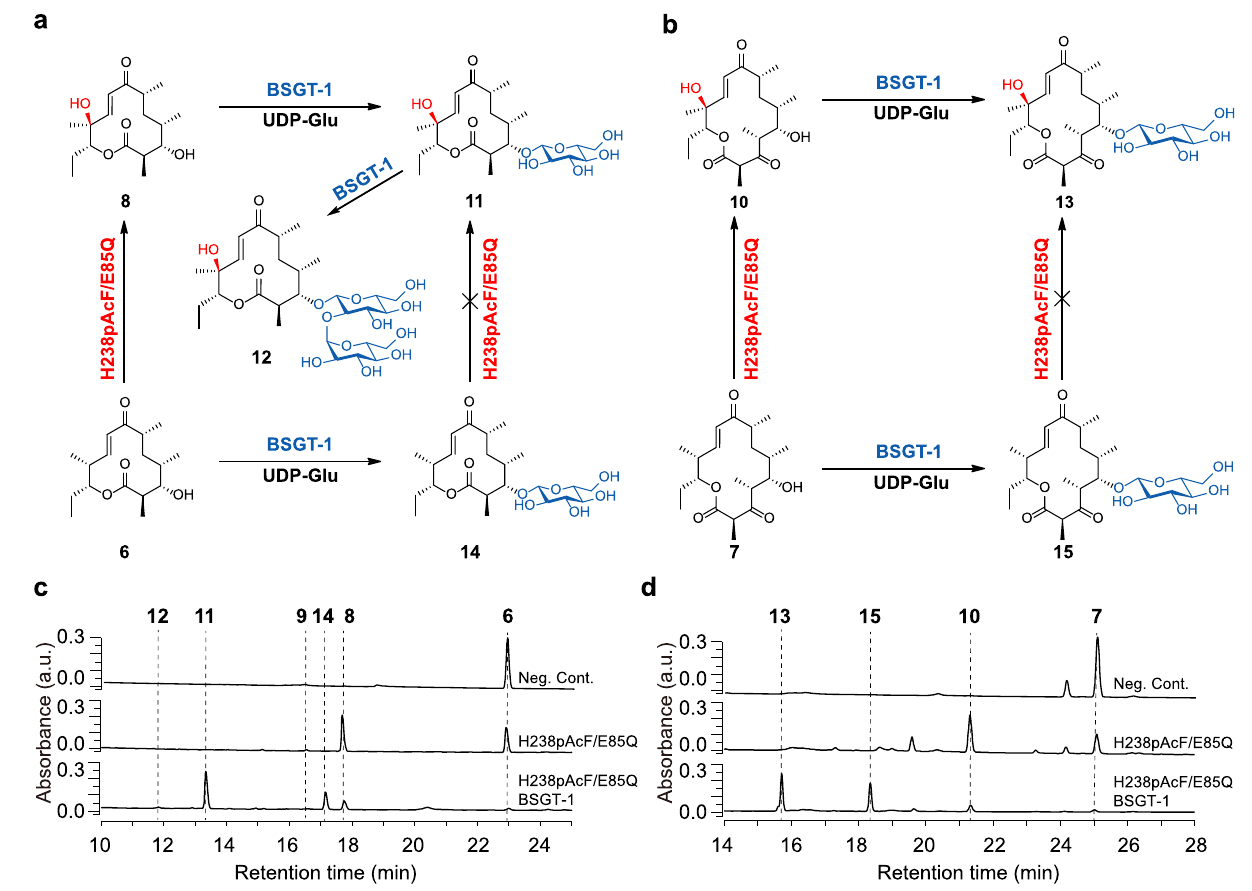
Fig.6|Thearti fi cialenzymecascadewithanoxidation-glycosylationorder.a , b Schemes of the PikC H238 p AcF/E85Q -BSGT-1 enzyme cascade with 6 ( a ) and 7 ( b ) as substrates. The functional groups introduced by P450 enzyme and